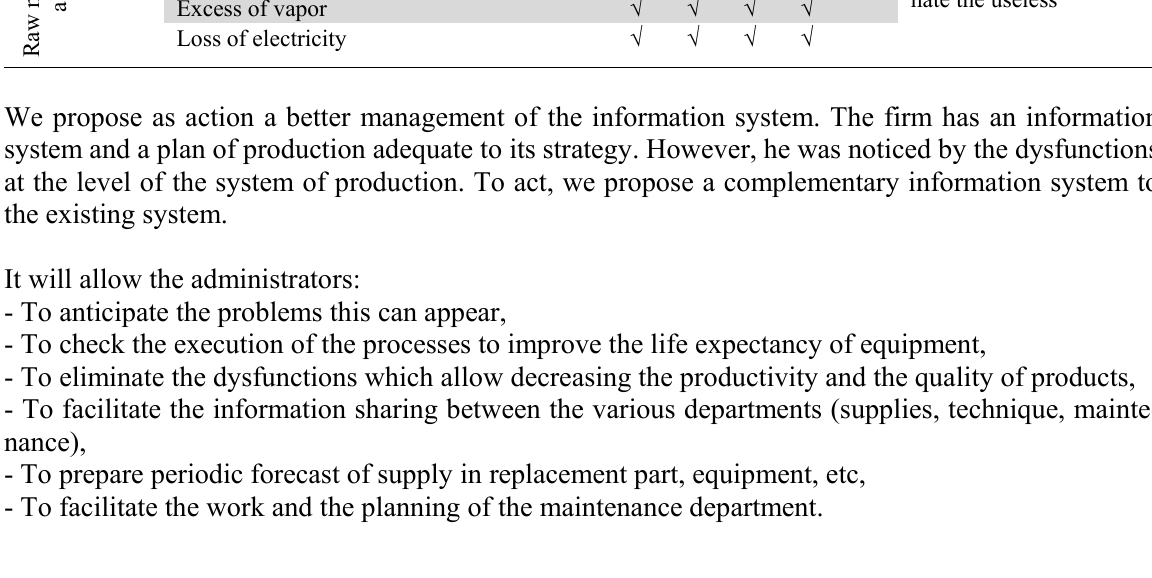
Application of the 5S on the identified dysfunctions (1st firm) Ishikawa Dysfunctions 5S Tool Corrective actions axis Defective and unimplemented maintenance √ Haste in the decision-making Deficiency in the periodic control hod s Databases instrumentation process incom- e t plete M Non-existence of working procedures No coordination between the